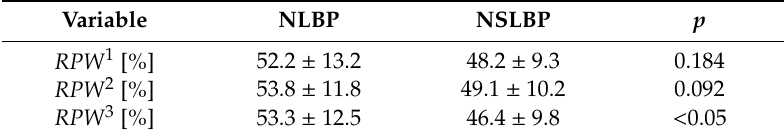
Table 4. Mean values of RPW i with standard deviations.